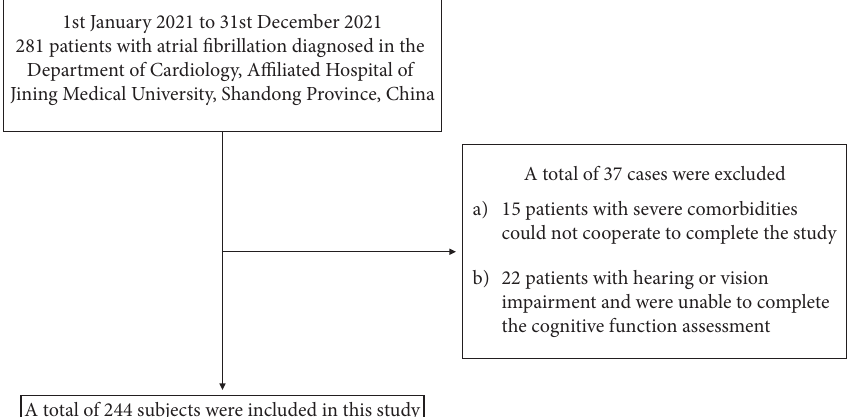
Figure 1: Inclusion/exclusion